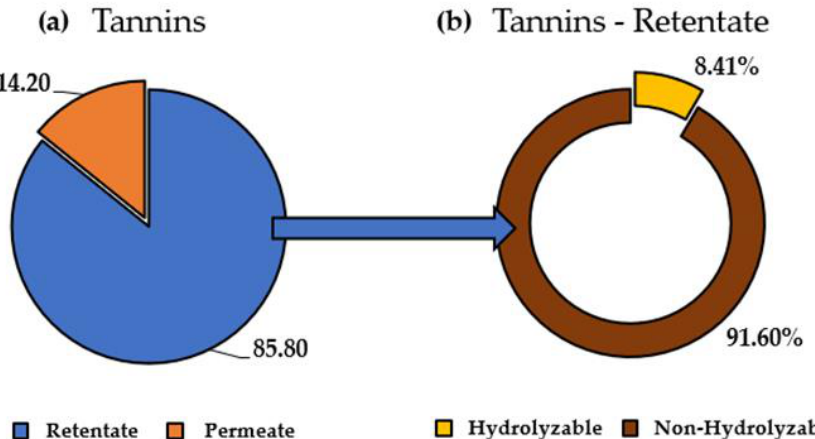
Figure 11. UF tannins mass balance, expressed as the percentage on TPC. ( a ) UF total tannin content; ( b ) tannin composition of retentate (hydrolyzable and nonhydrolyzable).